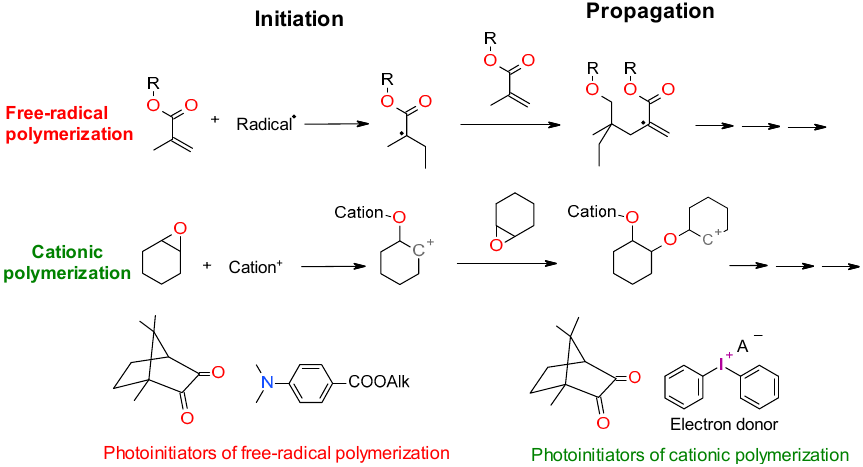
Figure 2. Mechanism of free radical polymerization and cationic ring-opening polymerization with their corresponding photoinitiation systems.